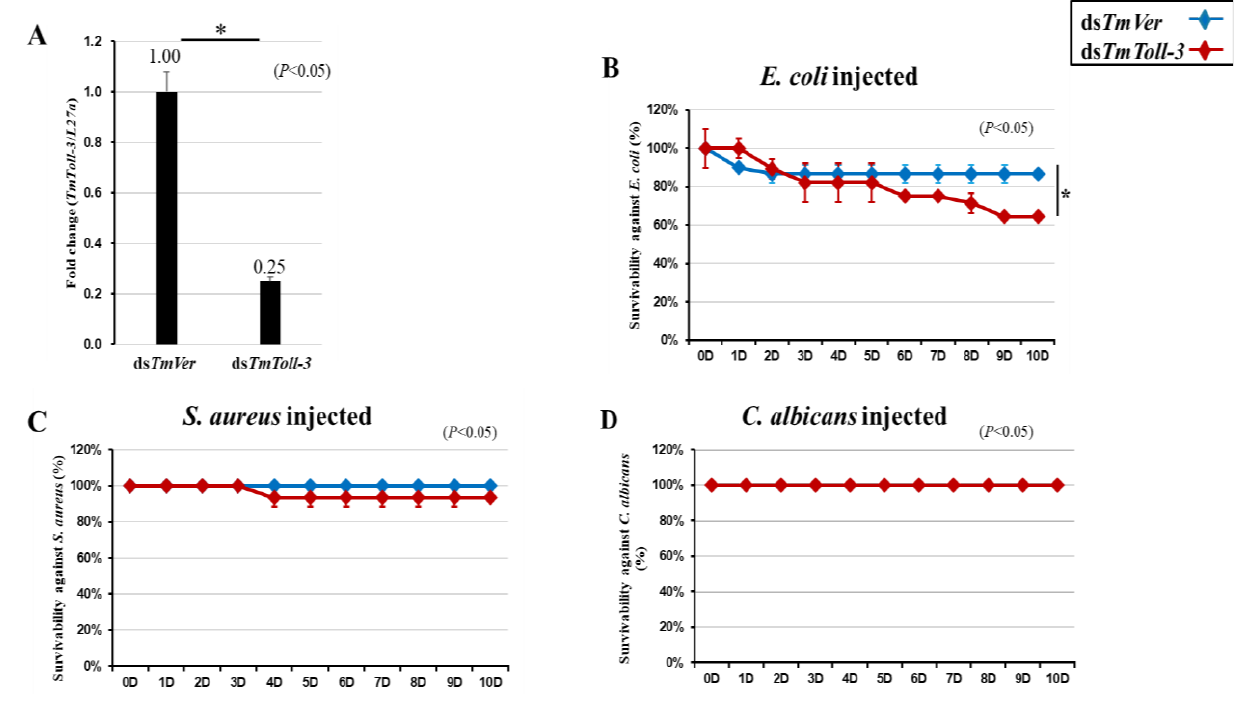
Figure 4. Effect of TmToll-3 gene silencing on T. molitor larval survival. The RNAi efficiency of ds TmToll-3 was measured by qRT-PCR 4 days after injection ( A ). TmToll-3 -silenced larvae were injected with E. coli ( B ), S. aureus ( C ), and C. albicans ( D ), and survival rates were monitored for 10 days post-pathogen injection ( n = 10 per group). The larval survival rates at 10 days post-microbial injection were 60% after E. coli injection and 100% after S. aureus and C. albicans injection compared with the survival rates of the ds TmVer -injected control group. Data were reported as averages of three biologically independent replicates. The asterisks indicate significant differences between the ds TmToll-3 - and ds TmVer -injected groups. Survival analysis was performed using Kaplan–Meier plots (log-rank chi-squared test; * p < 0.05).